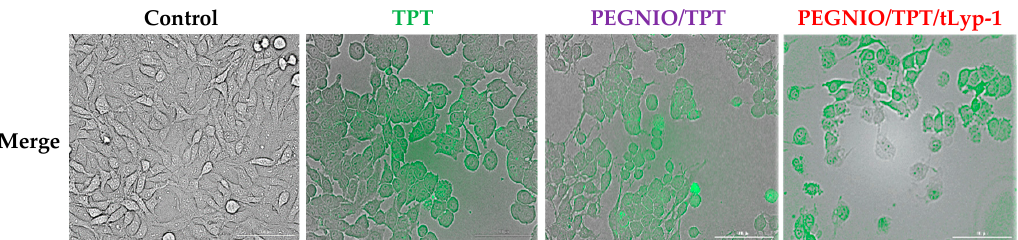
Figure 4. Fluorescence microscopy images of U87 cells without treatment and after incubation with TPT, PEGNIO/TPT, and PEGNIO/TPT/tLyp-1. The obtained fluorescence images were merged into the bright field picture (merge).